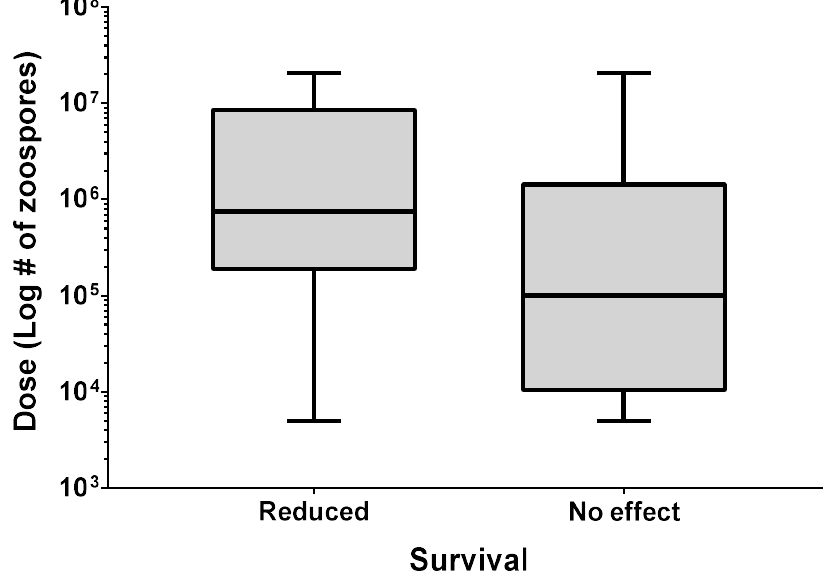
Figure 7. The effect of Bd dose (in log zoospores) on survival. These data are direct counts from Table 1. Experiments that use multiple dose levels or multiple strains were excluded. Reduced survival means mortality of hosts exposed to Batrachochytrium was significantly higher than control mortality. Here, we display the minimum, first quartile, median, third quartile, and maximum zoospore dose regarding host survival.